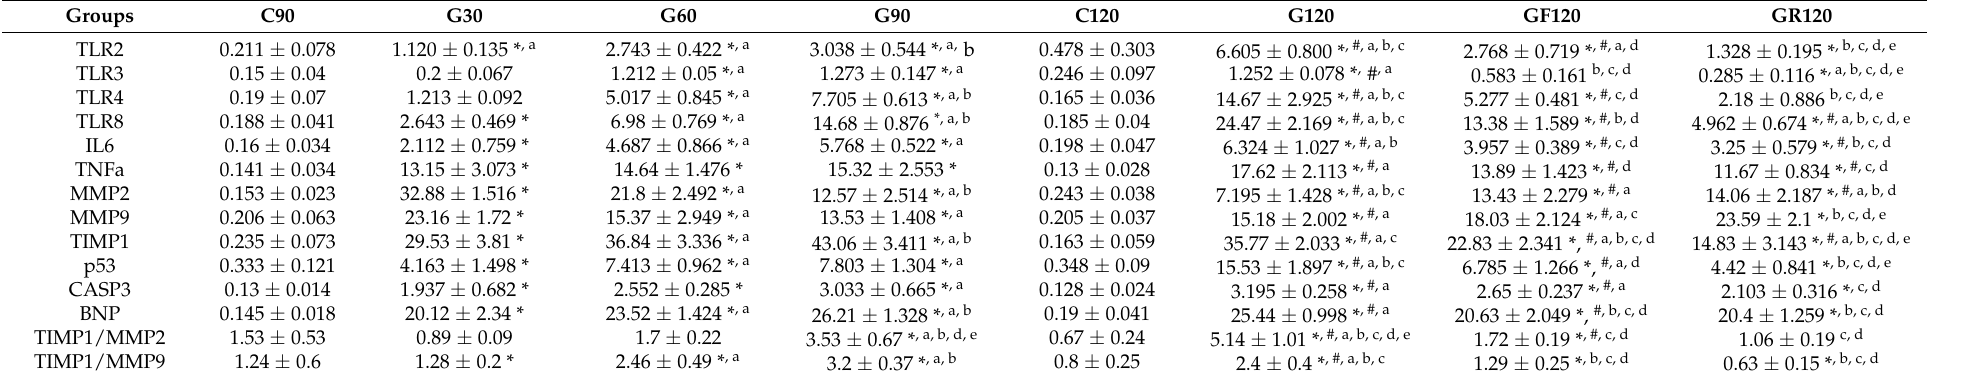
Table 2. Statistical analysis of mRNA expression for each biomarker in all study